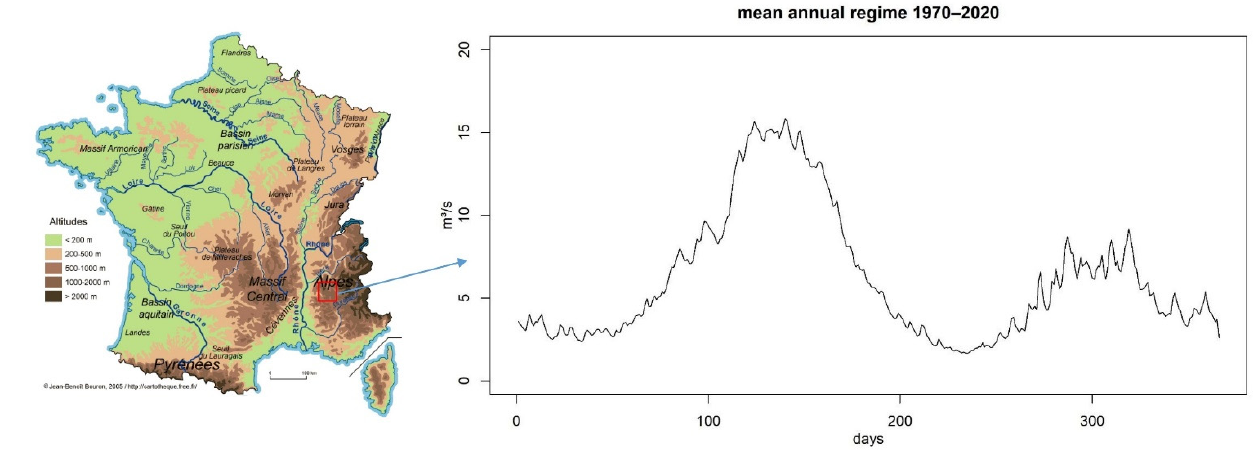
Figure 1. Location of the watershed and mean annual regime over the observation period Figure 1. location of the watershed and mean annual regime over the observation period 1970– 2013. Table 1. General descriptive information of the watershed (average values over the period 1970– 2013) .